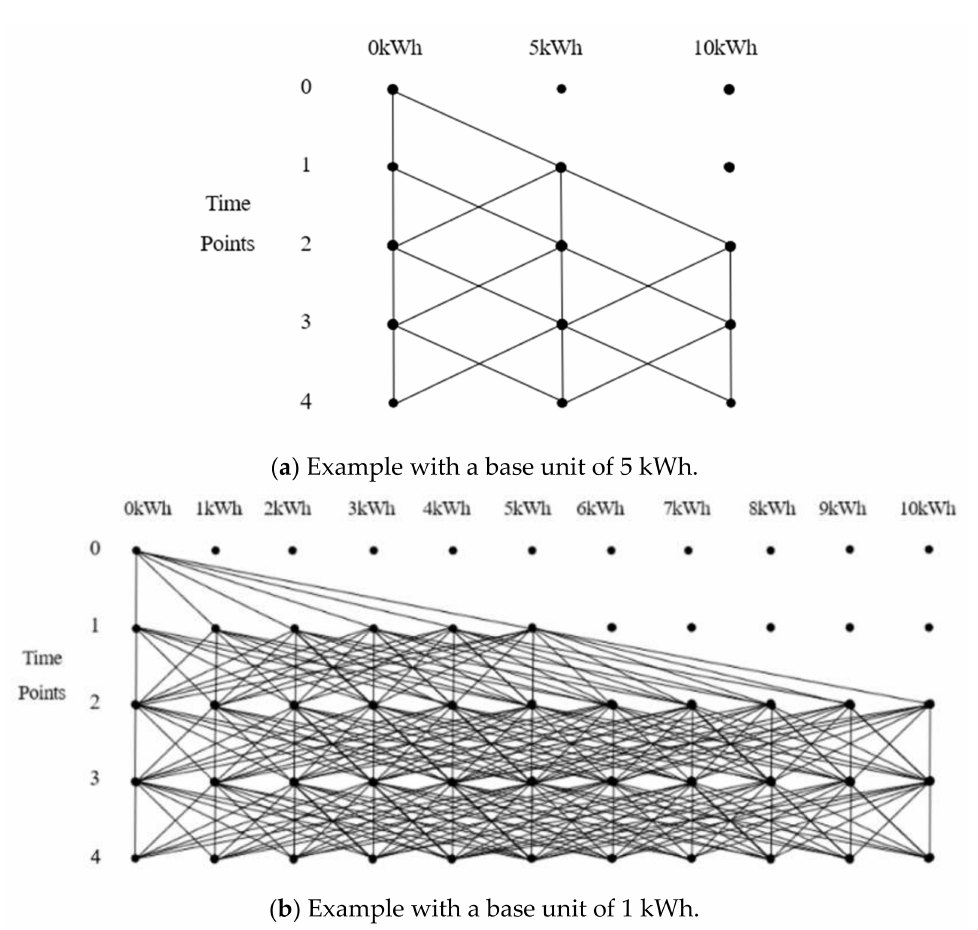
Figure 2. Schematic application of dynamic programming according to di ff erent base